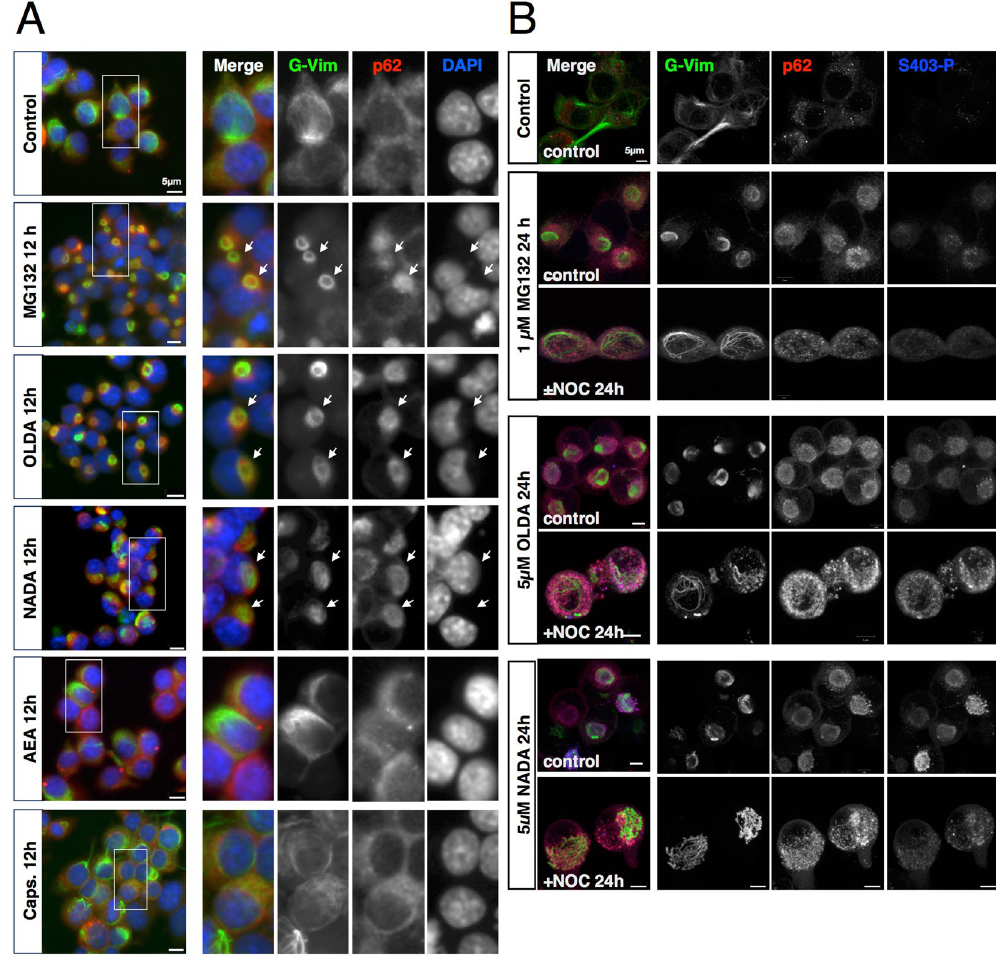
Figure 2. AcylDAs induce aggresome formation without proteasome inhibition. ( A ) N2a cells stably expressing GFP-vimentin were treated with 5 µ M OLDA, 5 µ M NADA, 10 µ M anandamide (AEA), 50 µ M capsaicin, or 1 µ M MG132 for 12 h as indicated. G-vimentin (G-Vim, green in merged images), p62 (red), and DAPI (blue; nucleus) were visualized by fluorescence microscopy. The arrows indicate aggresomes surrounded by the vimentin cage. ( B ) GFP-vimentin cell lines were treated with 1 µ M MG132, 5 µ M OLDA, or 5 µ M NADA and with or without 10 µ M nocodazole ( + NOC) simultaneously for 24 h as indicated. G-Vimentin (G-Vim, green), p62 (red), and S403-phospho-p62 (S403-P; blue) were visualized by confocal microscopy. Scale bars represent 5 µ